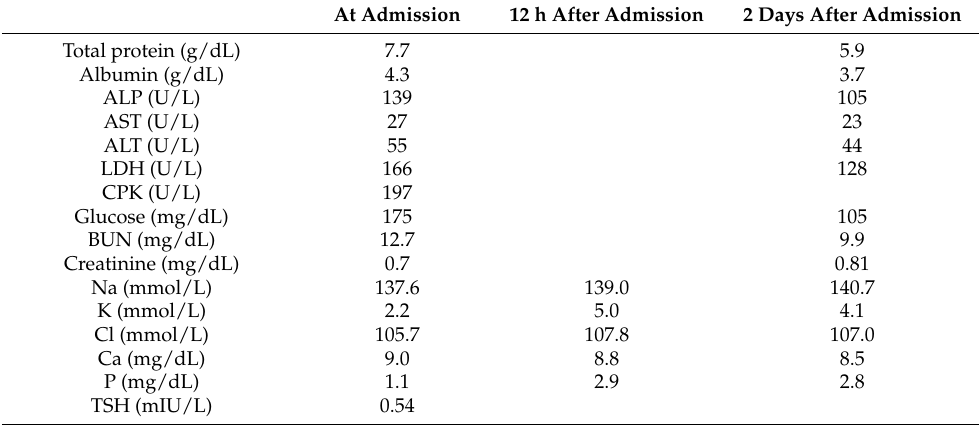
Table 1. Laboratory